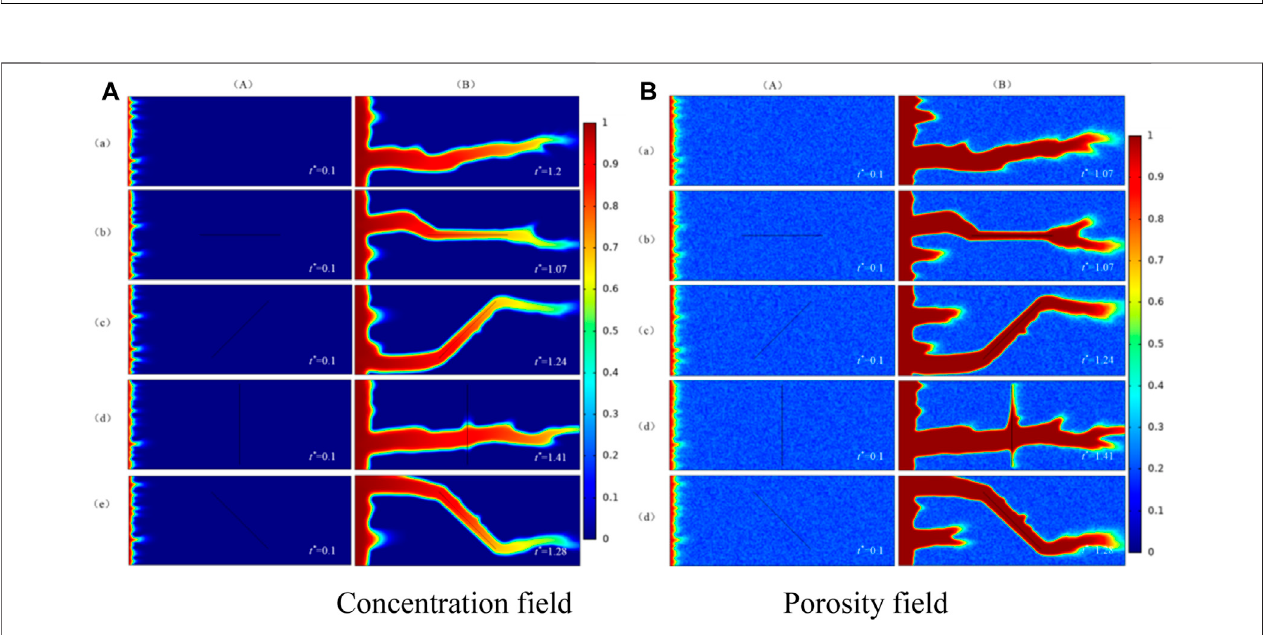
FIGURE 5 | Wormhole structure in the presence of different fracture orientations. (a) No fracture; (b) Fracture orientation is 0 ° ; (c) Fracture orientation is 45 ° ; (d) Fracture orientation is 90 ° ; (e) Fracture orientation is 135 ° ; (A) The initial phase; (B) The dissolution structure when injected acid breaks through core.